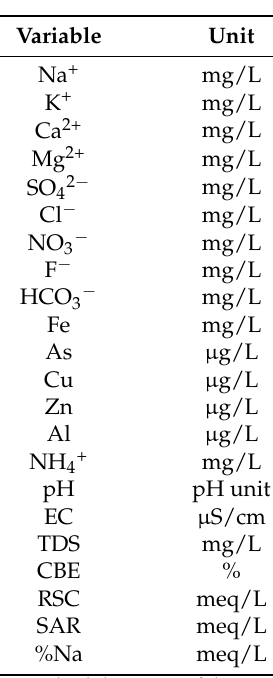
Table 2. Descriptive statistic for groundwater